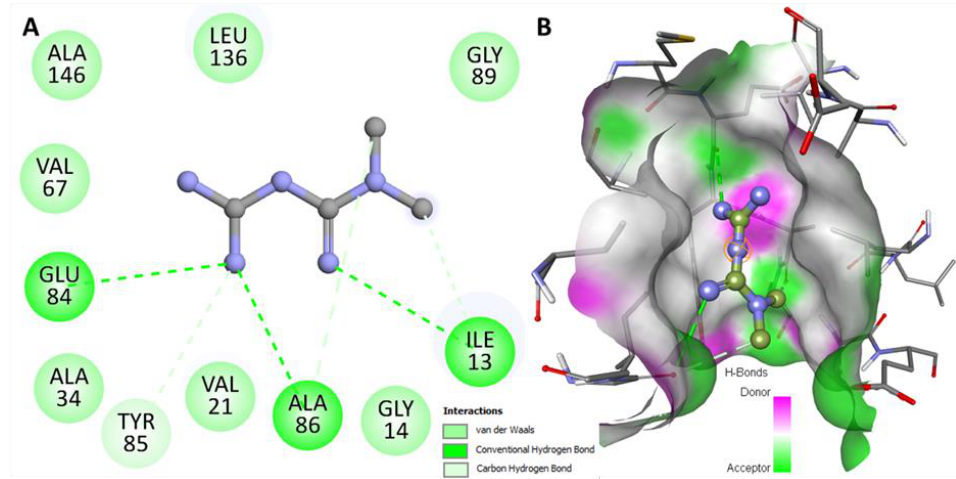
Figure 2. Detailed interactions between MARK4 and Mtf. ( A ) 2D plot of the protein – ligand interac- tions. ( B ) Mtf binding pocket showing different interactions.